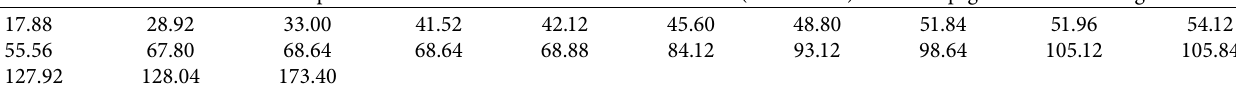
Table 9: First data set represents the number of revolutions to failure (in millions) of 23 deep-groove ball-bearings. 17.88